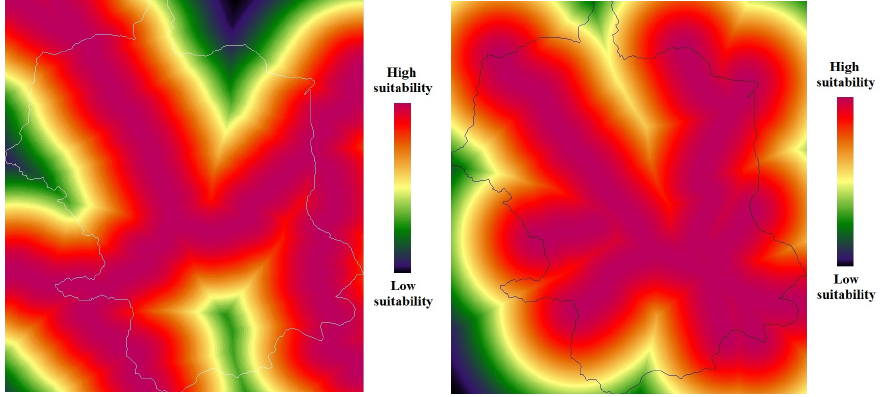
Figure 4. Suitability parameters: ( left ) distance to rivers (m); and ( right ) distance to roads (m).